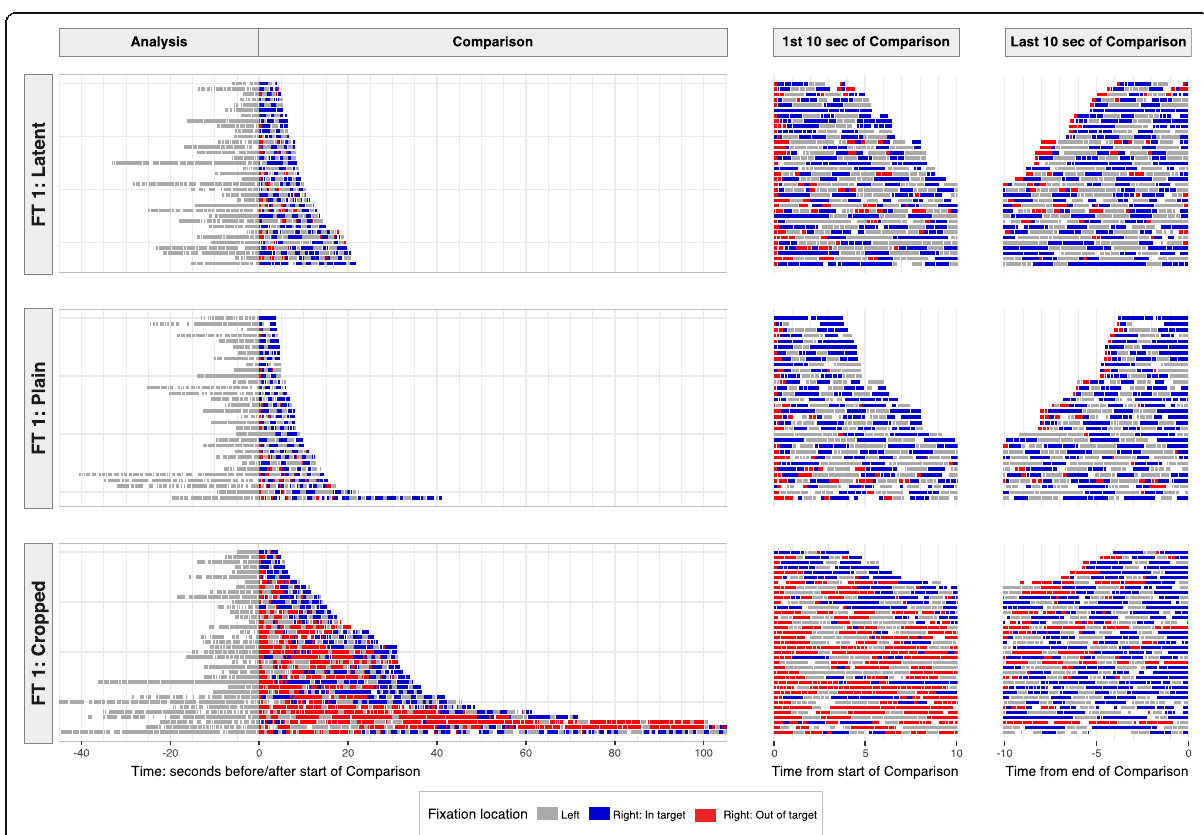
Fig. 9 Timeline view of all trials for one image set (FT1). Each row is one trial (i.e., different examiner); trials are sorted by Comparison time. (Left) Analysis and Comparison times are shown relative to the first fixation in the right image. (Right) First and last 10 s of Comparison phase. Each horizontal segment represents one fixation, with gaps shown in white (brief gaps are saccades; longer gaps are blinks or looking away from images). Longest timelines are truncated (longest Analysis times: 53, 64 s; longest Comparison times: 133, 167 s). Timelines for other image sets are in Additional file 1: Appendix SI-10. Left image fixations are not color-coded by location (in or out of the target area) because they are overwhelmingly in the target area (Additional file 1: Appendix